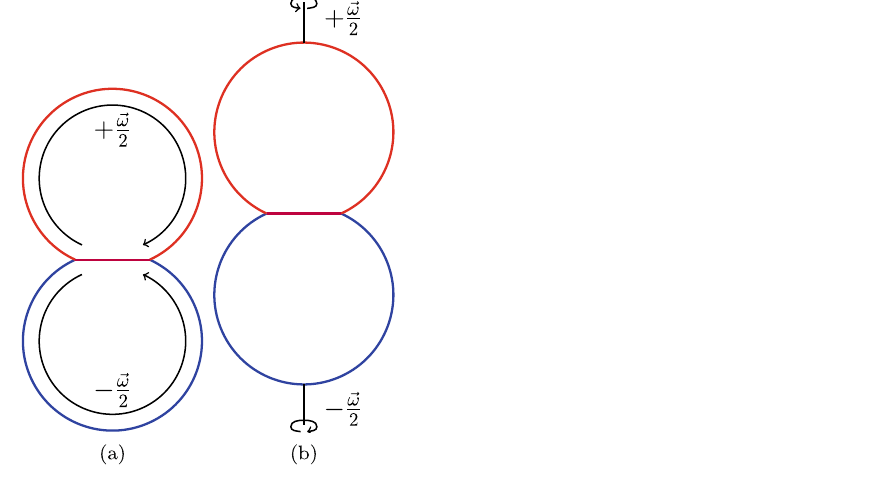
Figure 1. Schematic of ( a ) rolling and ( b ) twisting rotation of two grains in contact.